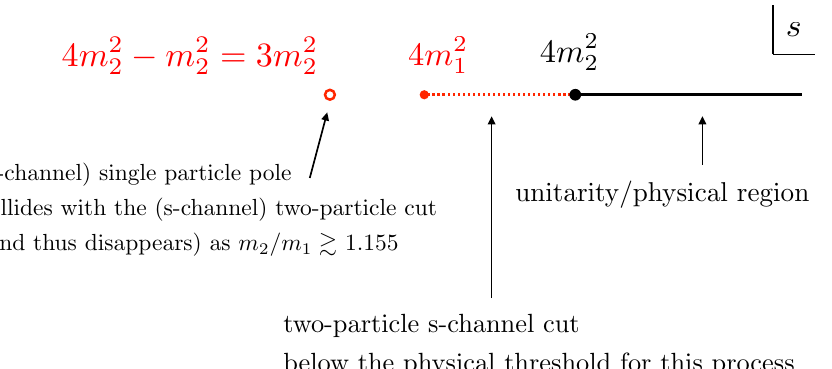
Figure 4. Analytic structure of the S and s-channel pole following from crossing symmetry S 22